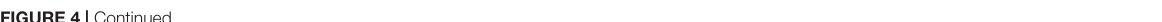
FIGURE 4 | Continued and blue column represents genes enriched only in plant–pathogen interaction pathway. Red, white, and blue represent upregulation, unchanged expression, and downregulation of mRNA level, respectively. (F) Graph of the protein interaction network of abnormally m 6 A-modified genes enriched in the plant–pathogen interaction pathway generated with the OmicStudio tool at https://www.omicstudio.cn/tool/56. Red and blue circles represent the source and target genes, respectively. The size of the circle represents the complexity of the